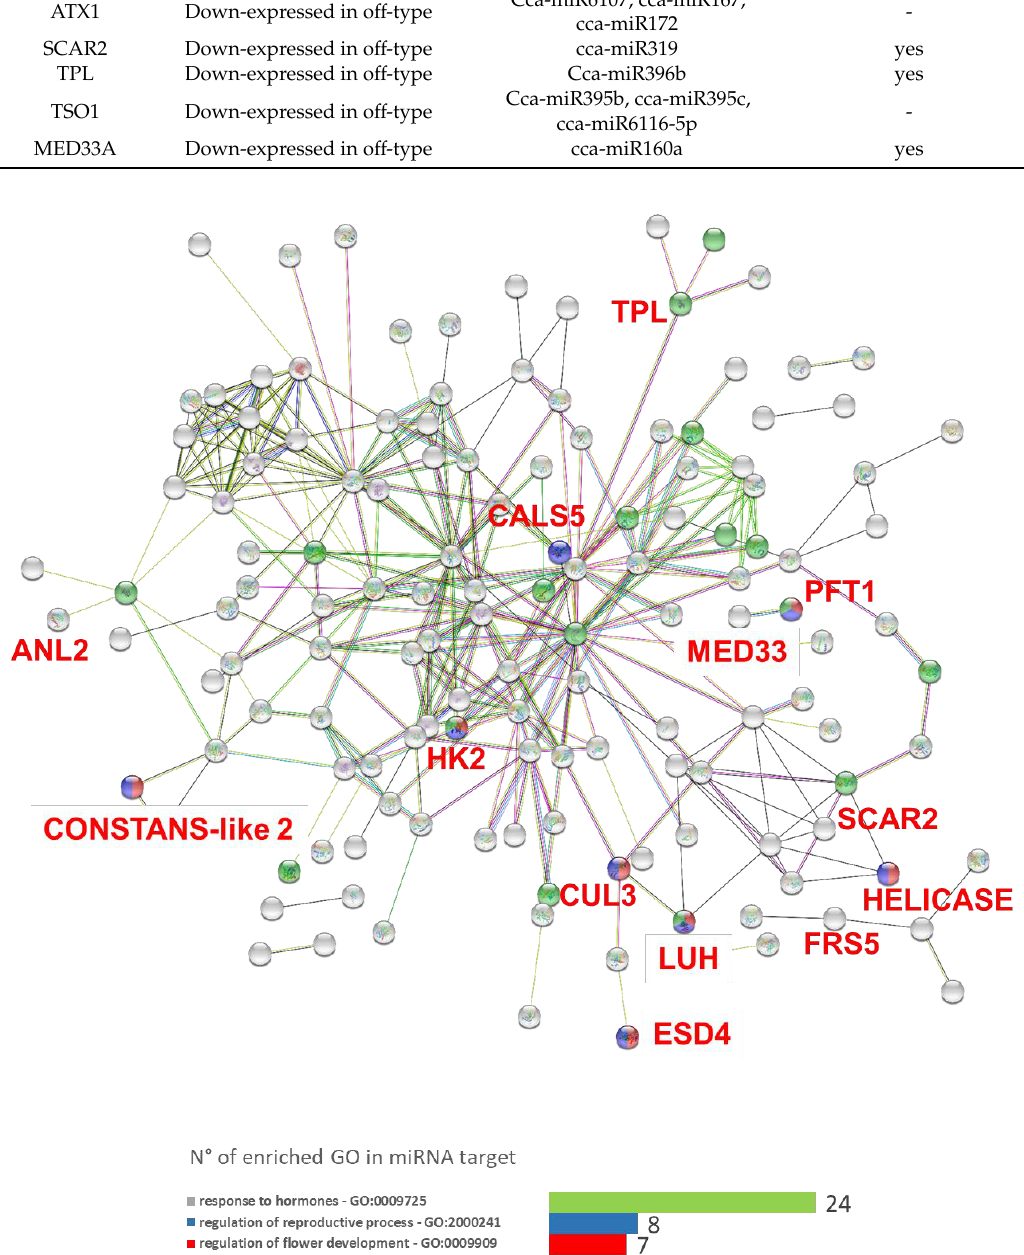
Figure 5. Interactome graph of the DML miRNA target and selected GO enrichments. Enrichments are highlighted as red / blue / green dots, as shown in the